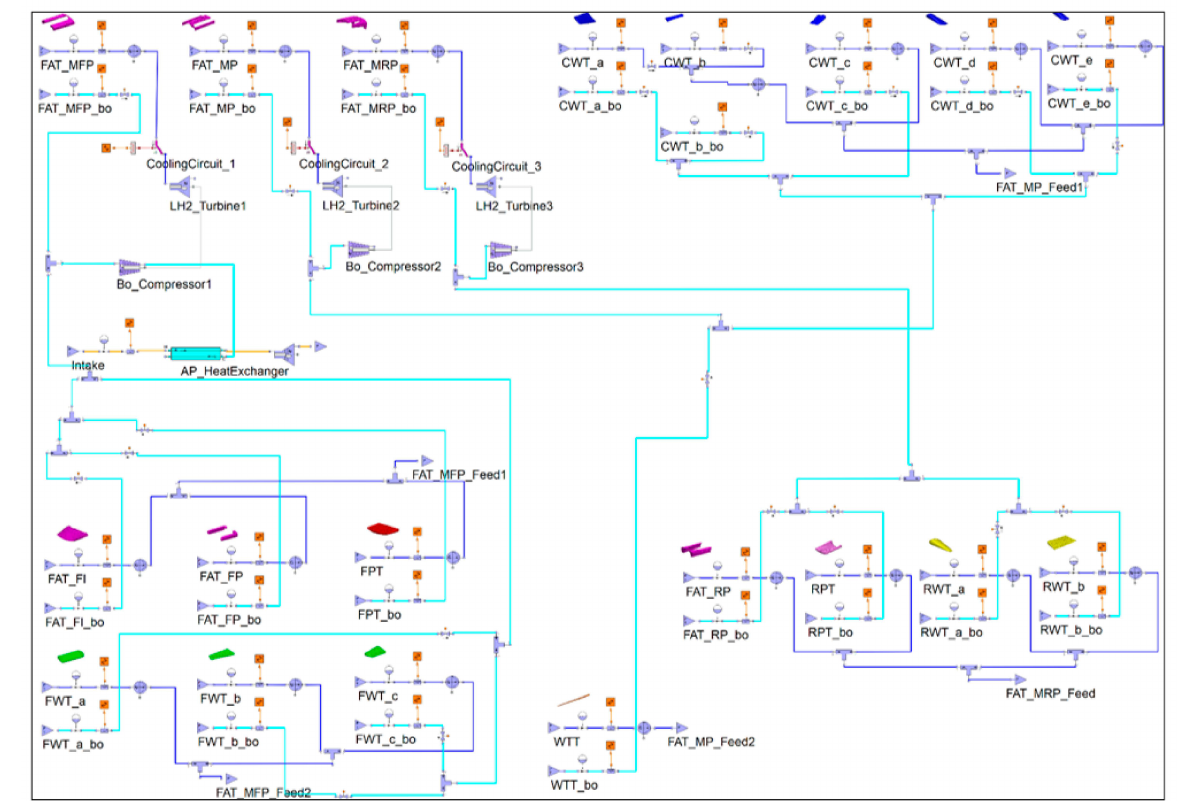
Figure 12. Overall thermal management system model in